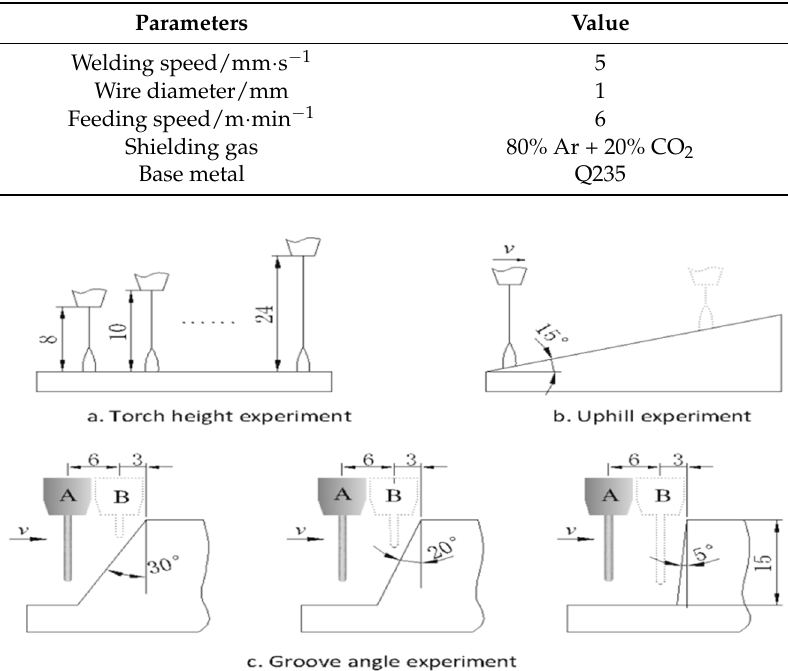
Table 2. Experiment parameters.